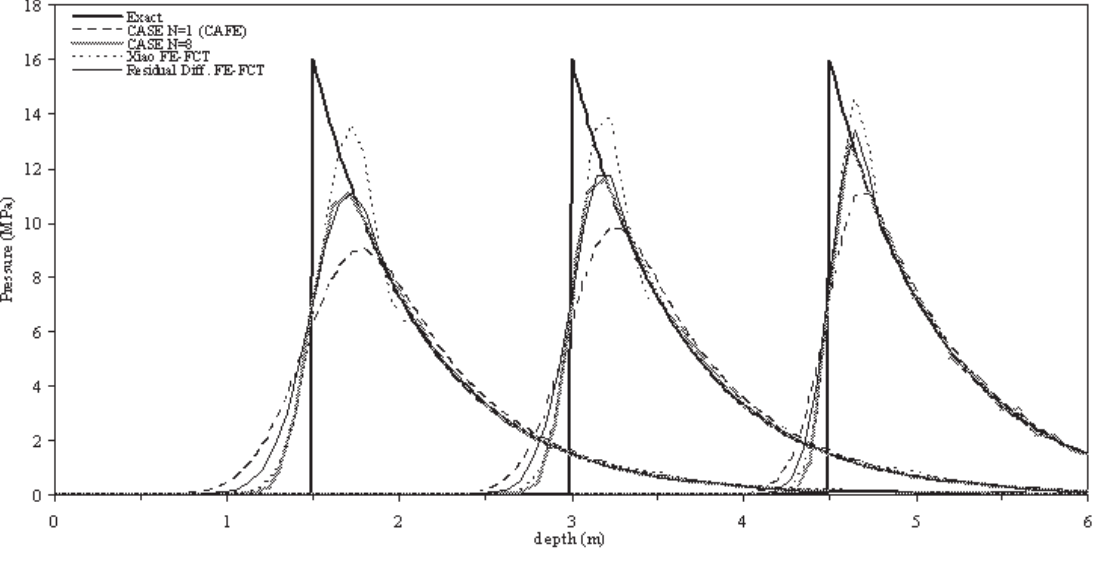
Fig. 1. Shock wave in a fluid bar results for 81 DOF mesh at times (from right to left) t = 1 ms, 2 ms, and 3 ms.